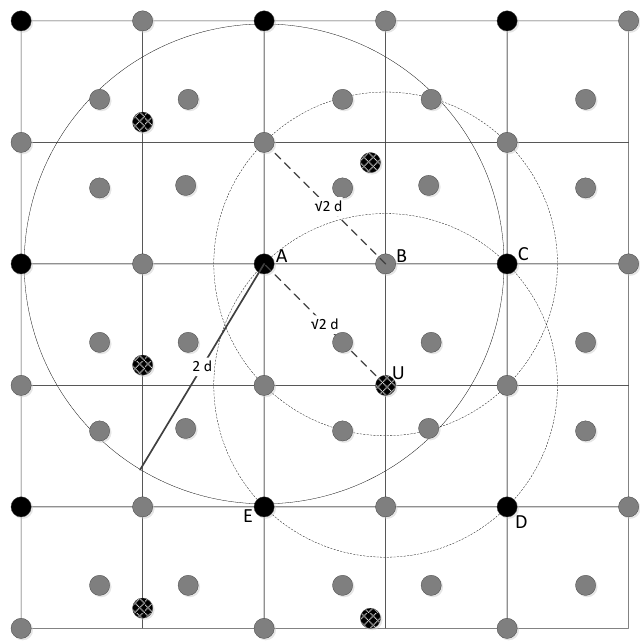
Figure 4. Uniform